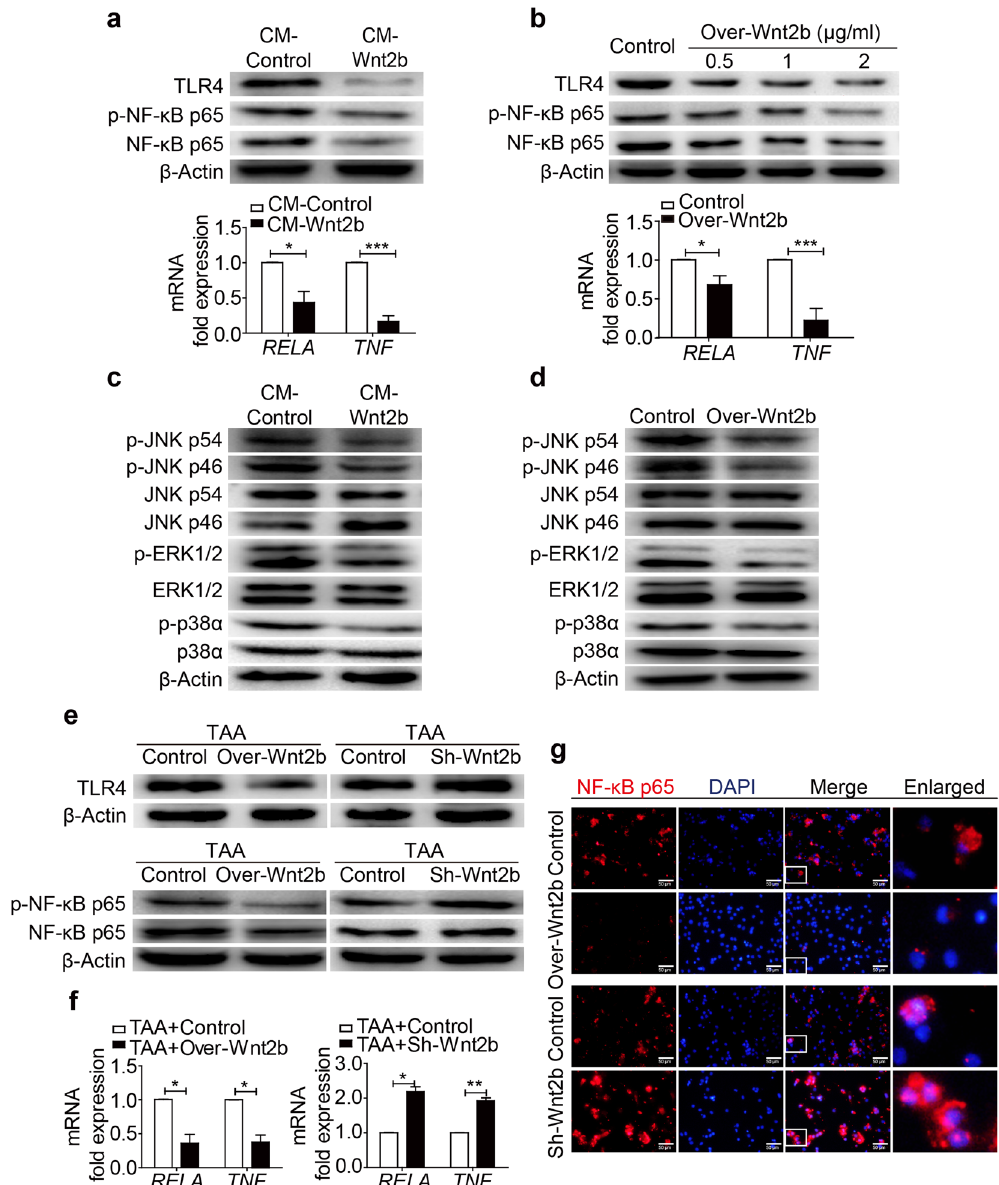
Figure 6. Wnt2b disturbs the TLR4 signaling transduction. ( a , b ) Protein levels of TLR4, p-NF- κ B p65 (Ser536) and NF- κ B p65 (upper), and mRNA levels of RELA and TNF (lower) in LX2 cells cultured in Wnt2b-CM ( a ), as well as in LX2 cells transfected with active Wnt2B-V5 or control plasmids ( b ). ( c , d ) Western blotting of the phosphorylation of MAPKs in LX2 cells cultured in Wnt2b-CM ( c) , and in LX2 cells transfected with active Wnt2B-V5 or control plasmids ( d ). ( e,f ) Protein levels of TLR4, p-NF- κ B p65 (Ser536) and NF- κ B p65 ( e ), and mRNA levels of RELA and TNF ( f ) in liver tissues from mice challenged with TAA combined with HD injection of pRK5-mWnt2b/sh-Wnt2b construct or control vector as depicted in Fig. 3. ( g ) Immunofluorescence staining of NF- κ B p65 in HSCs isolated from mice challenged with TAA combined with HD injection of pRK5-mWnt2b (upper) / sh-Wnt2b (lower) construct or control vector as depicted in Fig. 3. Cropped blots are displayed; Full-length blots are presented in Supplementary Fig. S8. Statistical analysis provided the mean ± SE (n = 6/group), * P < 0.05, ** P < 0.01, *** P <